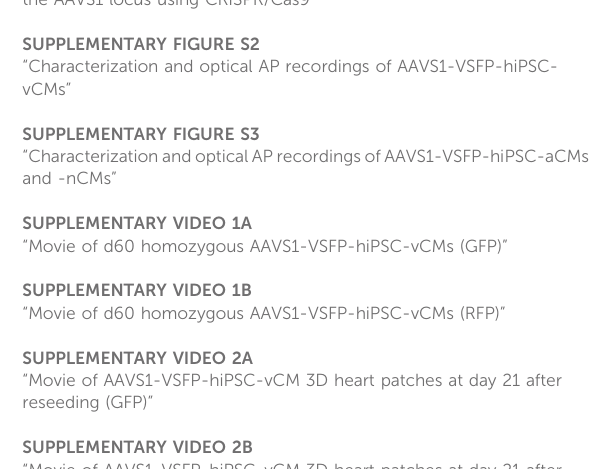
SUPPLEMENTARY FIGURE S1 “ GenerationofthevoltagesensorhiPSClinesbyinsertionoftheVSFPinto the AAVS1 locus using CRISPR/Cas9 “ SUPPLEMENTARY FIGURE S2 “ Characterization and optical AP recordings of AAVS1-VSFP-hiPSC- vCMs ” SUPPLEMENTARY FIGURE S3 “ Characterization andopticalAP recordingsofAAVS1-VSFP-hiPSC-aCMs and -nCMs